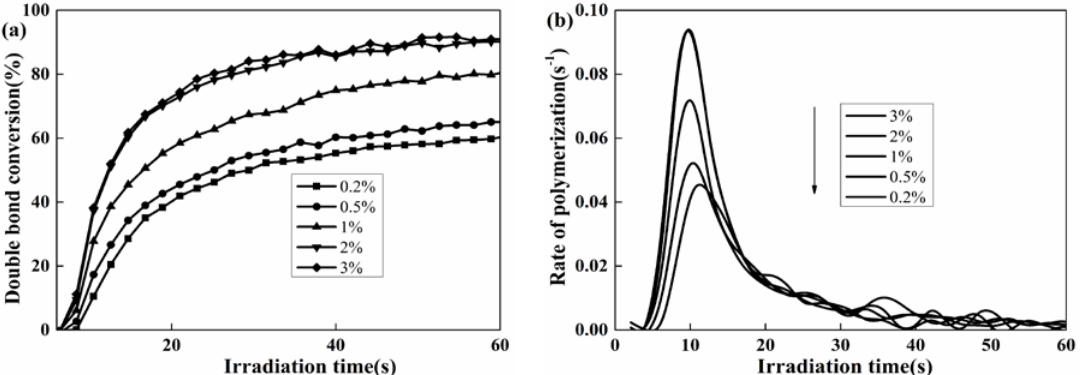
Figure 3. Effect of photoinitiator 184 content on the double bond conversion ( DC ) ( a ) and the rate of polymerization ( R p ), ( b ) Coating composition: HTPU, PETMP (2 wt %), EFCSA (2 wt %).